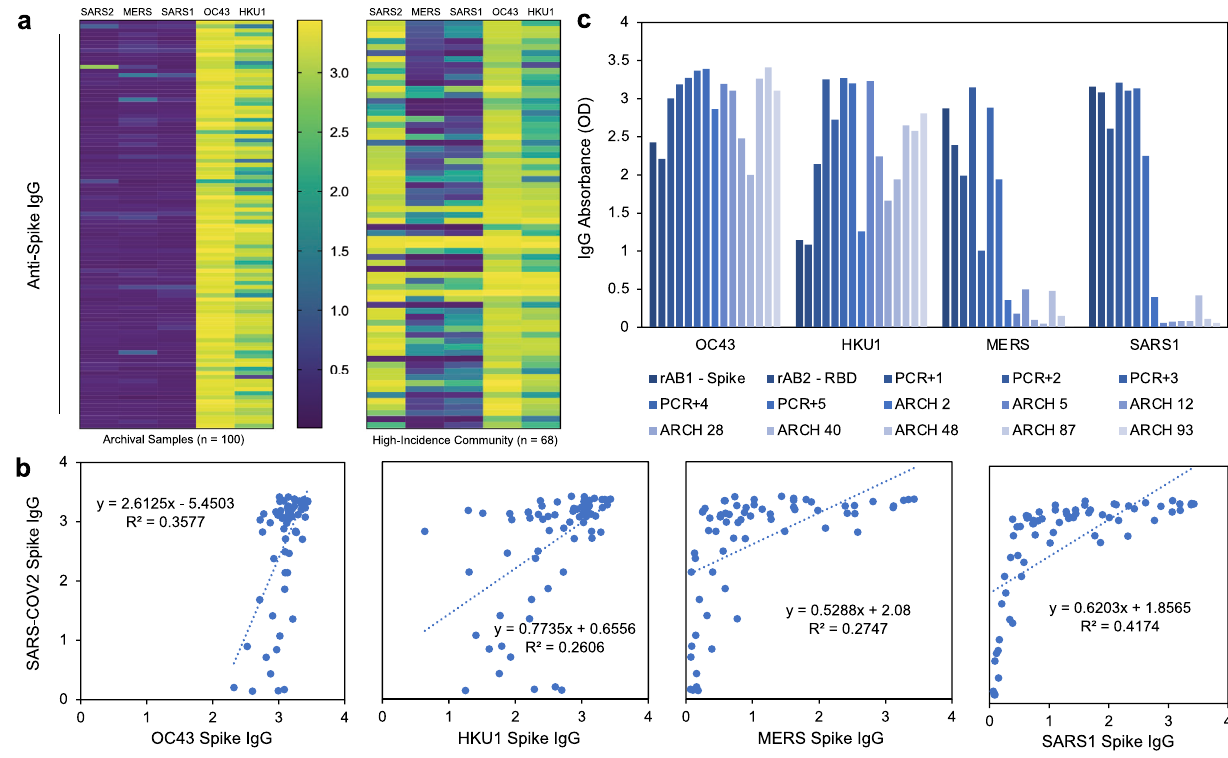
Fig. 6 Cross-evaluation of high seroprevalence community samples with spike antigens from other coronaviruses. a IgG absorbance of spike antigens from SARS-CoV-2, previous epidemic (MERS and SARS1), and seasonal (OC43 and HKU1) coronaviruses in archival pre-2019 samples (left) and high- incidence community (right). Color scale: yellow = high OD (4), purple = low OD (<0.5). b Scatter plots (with linear models and R-squared values) between IgG signal from SARS-CoV-2 spike and other coronavirus spike proteins. c Signal intensity for recombinant antibody control (rAB1 = spike monoclonal; rAB2 = RBD monoclonal), known SARS-CoV-2 nasal swab positive patient control (PCR + ), and pre-2019 archival control (ARCH) samples for OC43, HKU1, MERS, and SARS1. Source data are provided as a Source Data fi